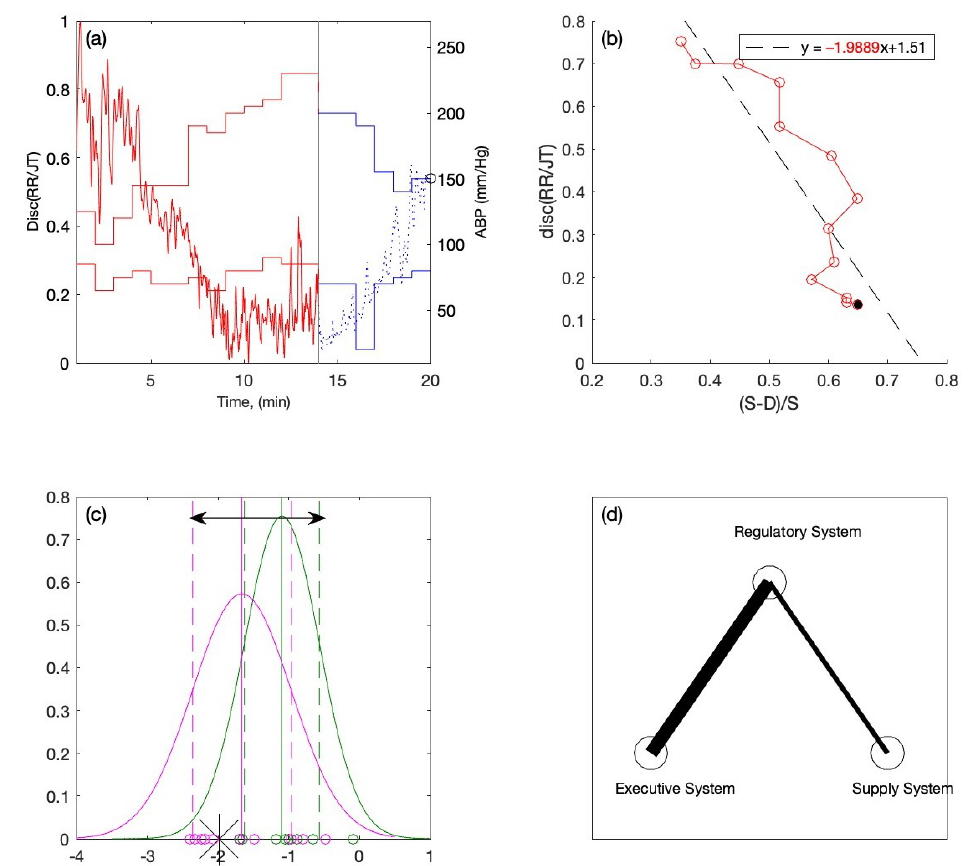
Figure 7. One case for an individual with ( a ) Discriminant RR/JT vs. time graph and ABP vs. time graph, ( b ) Linear regression graph and the slope coefficient ( − 1.9889) during the load phase, ( c ) Locat- ing the individual within the variation interval of the Gaussian distribution graph, ( d ) Visualization of the individual inside the triangle